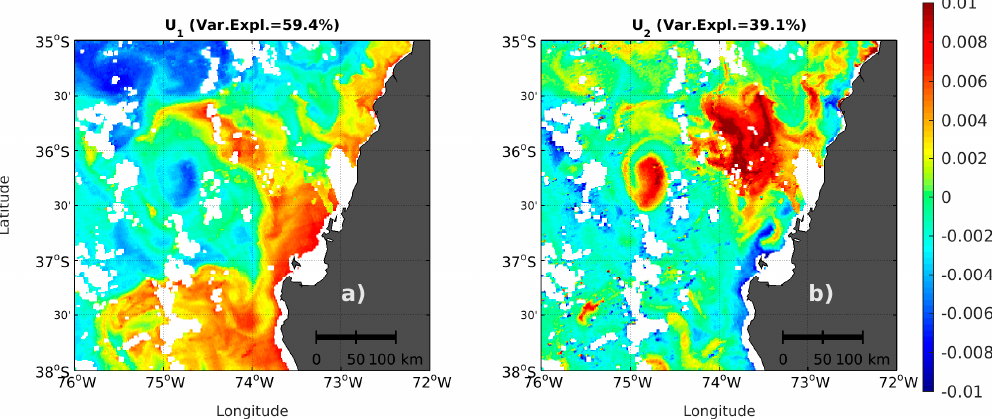
Figure 6. The spatial pattern of the: first U 1 ( a ); and second U 2 ( b ) orthogonal modes derived from the SVD of a space–nLw matrix, composed by the average MODIS-A nLw data from the 4–6 February